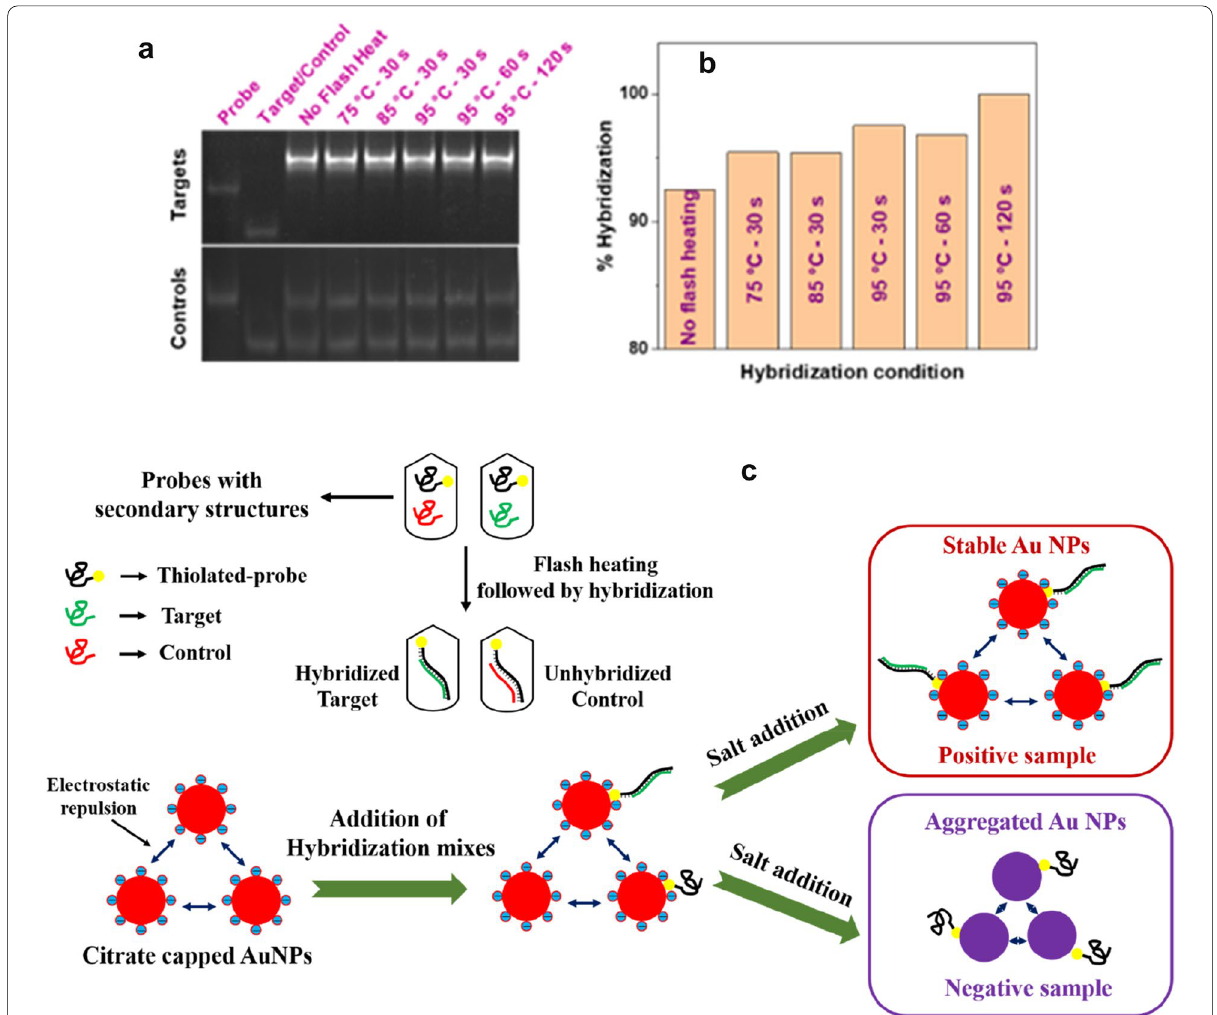
Fig. 1 a Polyacrylamide gel electrophoresis of the probe, target and control DNA subjected to different hybridization conditions and b the corresponding percentage hybridization quantification using ImageJ software. c Schematic representation on the mechanism of the sensing strategy employed in this